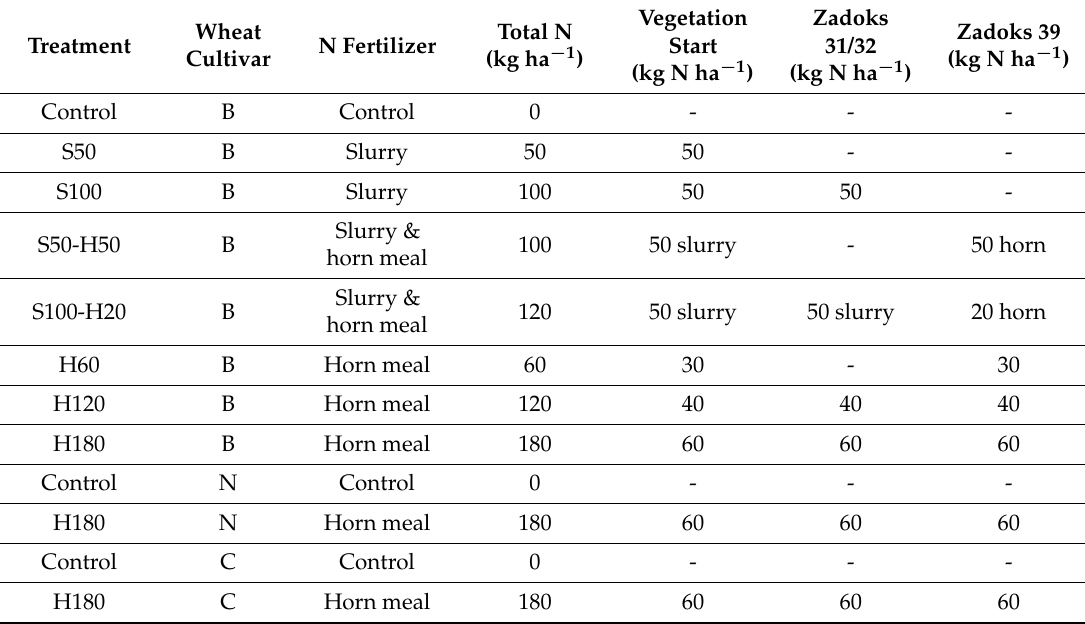
Table 2. Treatments in the organic N trial differing in winter wheat cultivar (Bussard: B, Naturastar: N, Capo: C), amount of N fertilization and temporal distribution of N